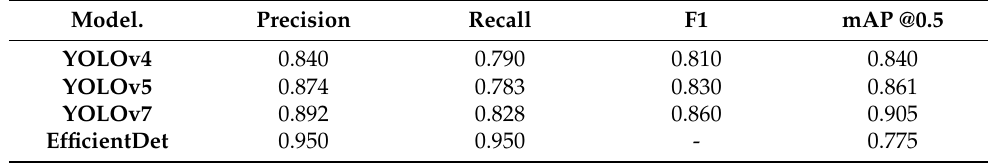
Table 1. Performance evaluation summary of training datasets for apple detection models.